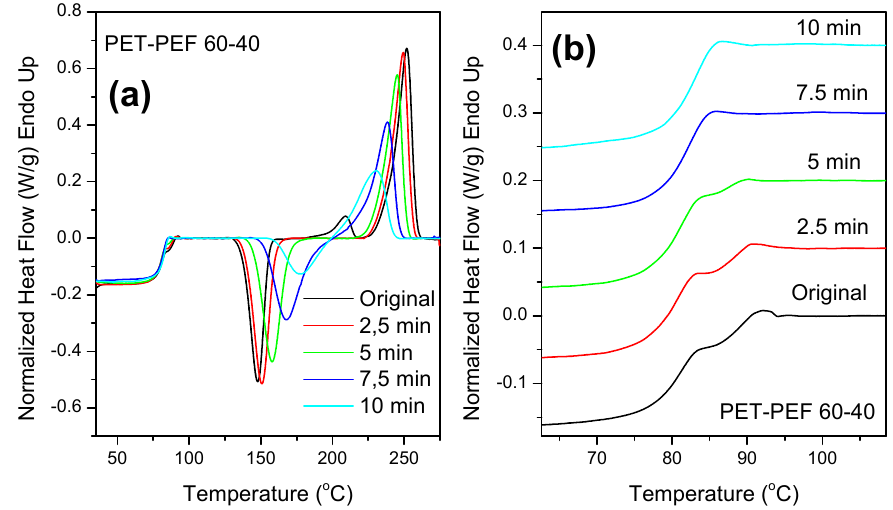
Figure 10. ( a ) Effect of blending time on the DSC curves of a PET-PEF 60-40 copolymer, ( b ) zoom-in